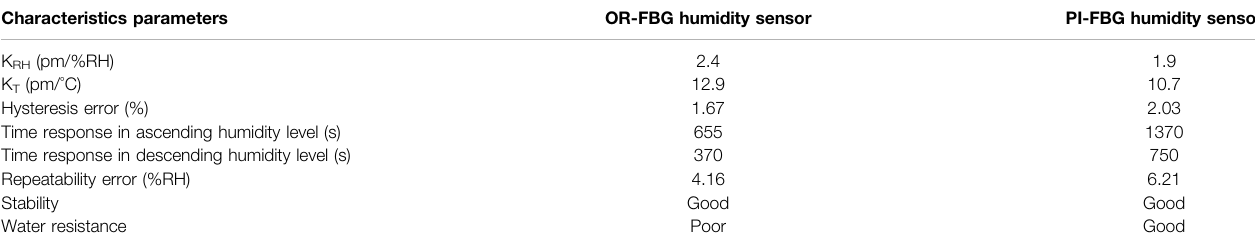
TABLE 2 | Performance comparison of the two humidity sensors (Guo et al., 2021a). Characteristics